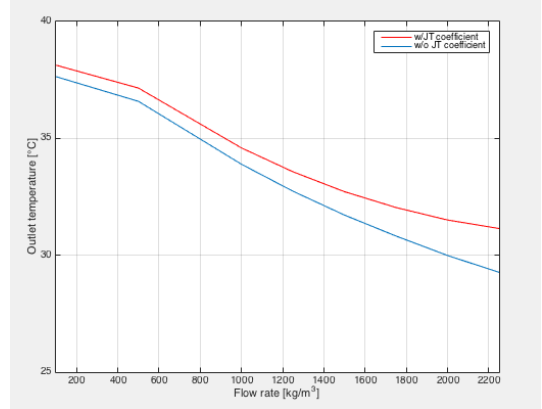
Figure 16: Temperature distribution( ρ = 1700 kg/m 3 )